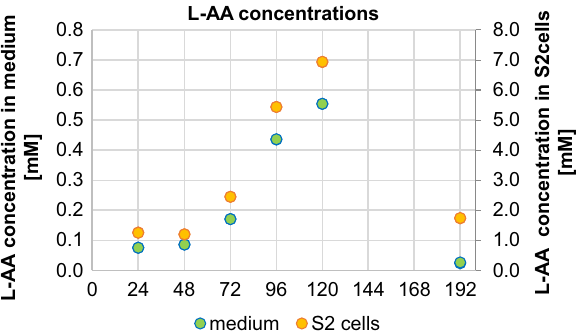
Figure 7. L-ascorbic acid concentration in supplemented Drosophila medium and in S2